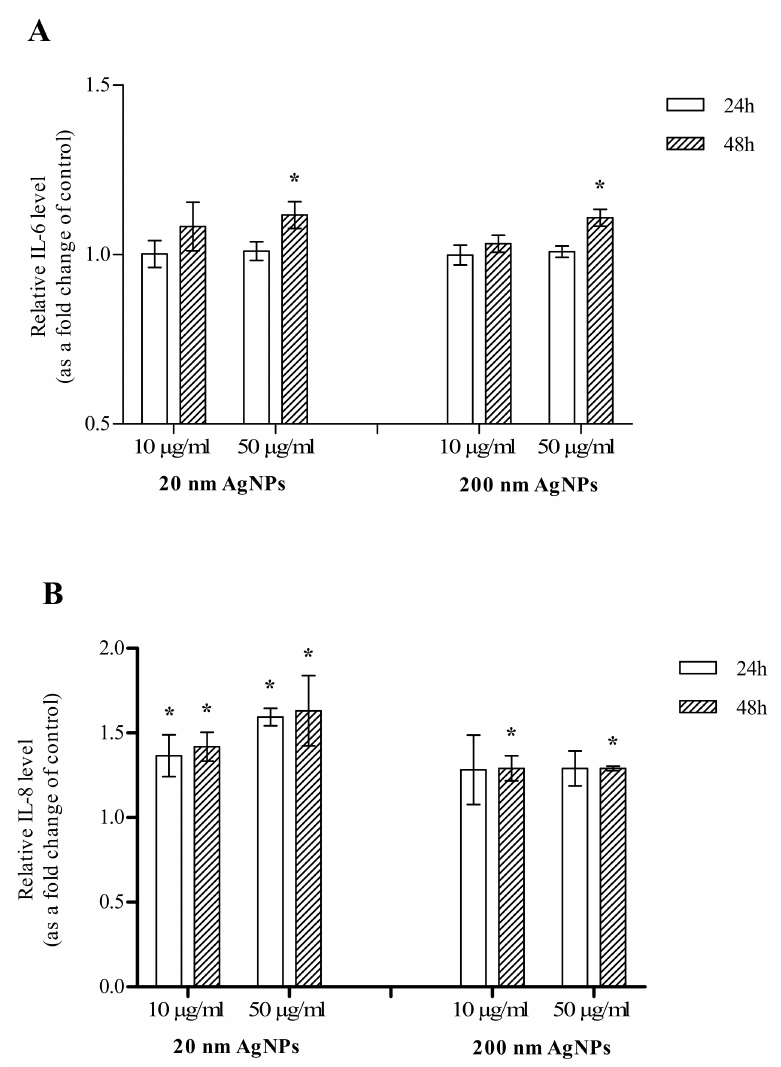
Figure 5. Interleukin 6 (IL-6) ( A ) and interleukin 8 (IL-8) ( B ) levels in growth media of MDA-MB-436 cells treated with 20 or 200 nm AgNPs. The graph presents the fold change of IL-6 / IL-8 level calculated for samples incubated with AgNPs, relative to untreated control. Data were expressed as mean ± standard deviation ( n = 3). Statistical significance: * p <